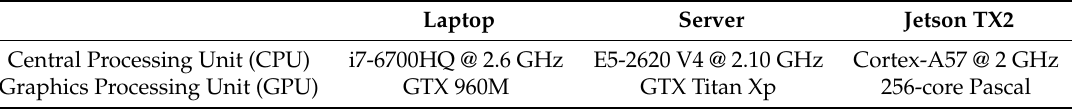
Table 1. Details of platforms using in the processing time